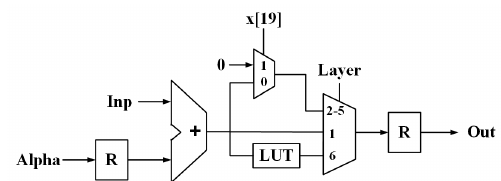
Figure 5. The post-processing